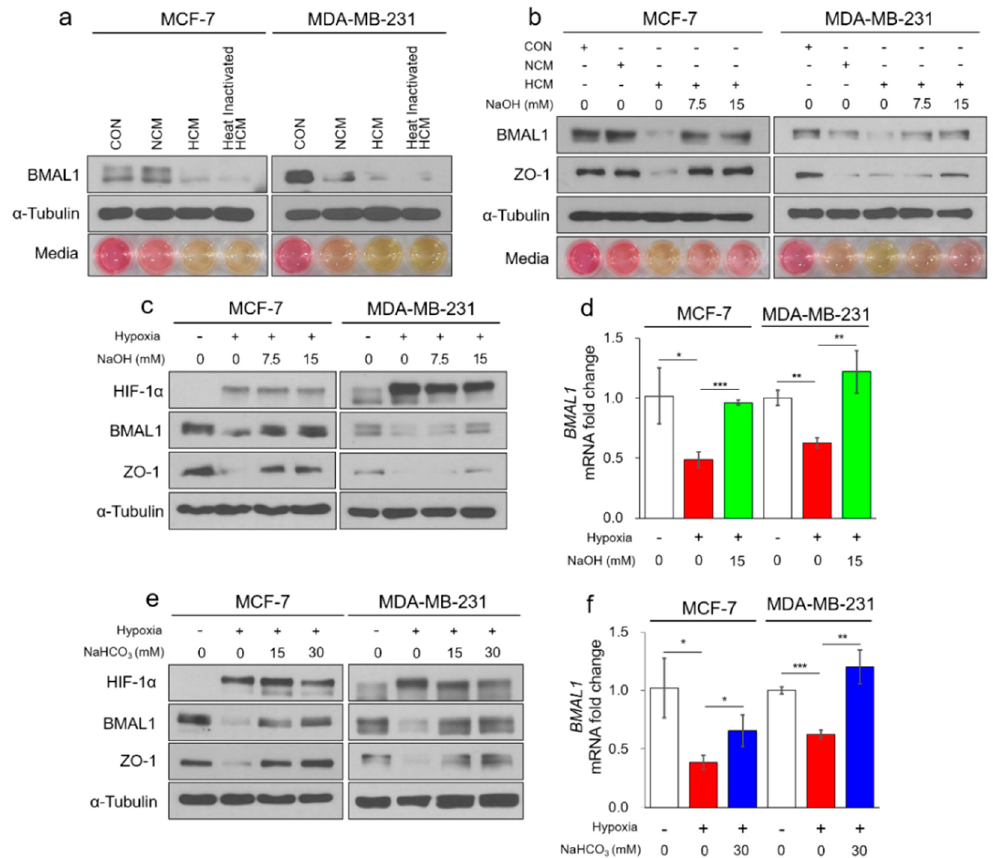
Figure 2. Hypoxia-mediated acidosis reduces circadian BMAL1 expression in breast cancer cells. ( a ) MCF-7 and MDA-MB-231 were treated with fresh media (control; CON), normoxic conditioned media (NCM), hypoxic conditioned media (HCM), or heat inactivated HCM for 24 h. Cell lysates were analyzed by immunoblotting. Representative images of cultured media are shown (bottom panel). ( b ) MCF-7 and MDA-MB-231 were treated with fresh media, NCM, HCM, or NaOH treated